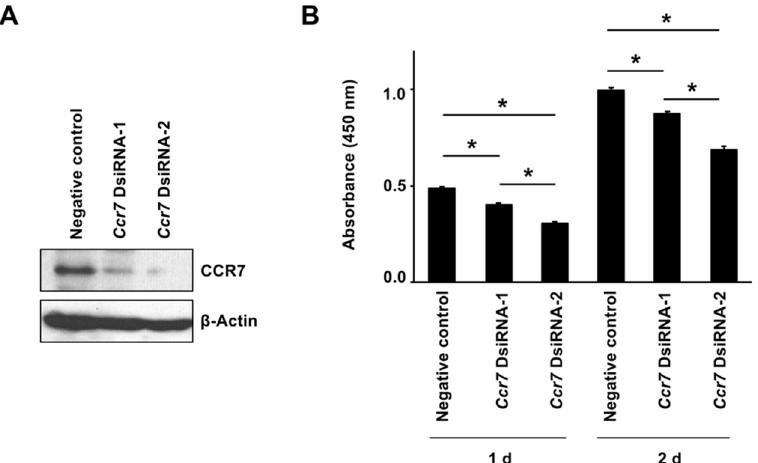
Figure 8. Effect of Ccr7 knockdown on cell growth in KMPC44 cells. KMPC44 cells were inoculated in a 100-mm dish at a density of 6 × 10 4 cells/mL, treated with Ccr7 dicer-substrate short interfering RNA (dsiRNA) for 1 d, and then the new dsiRNA was boosted for 1 d. Subsequently, the cells with Ccr7 knockdown were reinoculated in a 24-well plate at a density of 5 × 10 4 cells/mL, adhered for 1 or 2 d. ( A ) CCR7 and β -actin protein expressions in KMPC44 cells with or without Ccr7 knockdown for total 2 d were observed using western blot analysis. ( B ) The cell growth of KMPC44 cells was determined using a WST-1 cell viability assay. Mean ± SE ( n = 6). * p < 0.05.